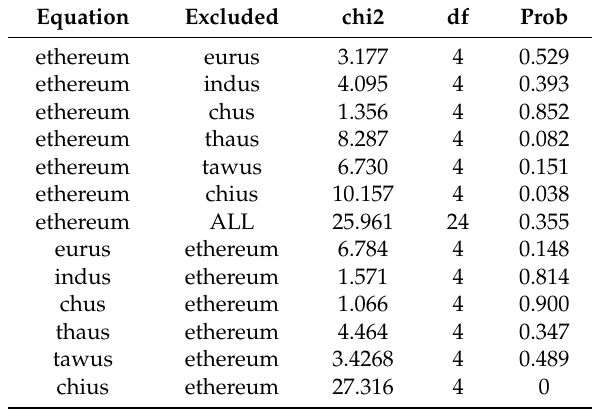
Table 7. Granger causality test for Ethereum vs. relevant fiat currencies.